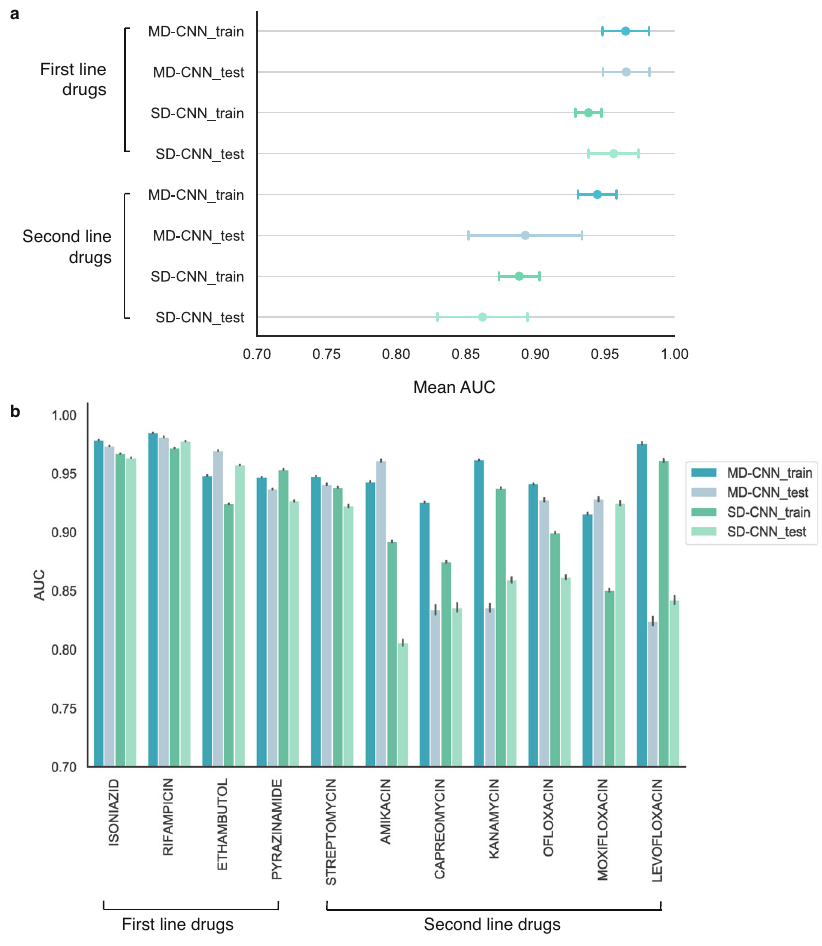
Fig. 3 MD-CNN and SD-CNN model generalize well on held-out test data. Performance of CNN models trained on the entire training dataset evaluated on either the entire training dataset or the entire hold-out test dataset ( N = 12,848 isolates). a data are presented as mean AUCs ± 95% con fi dence intervals for fi rst-line (4 drugs) and second-line drugs (7 drugs). b AUC for each drug evaluated on either the entire training or entire hold-out test dataset. Cipro fl oxacin and ethionamide (both second-line drugs) were not assessed due to low numbers of resistant